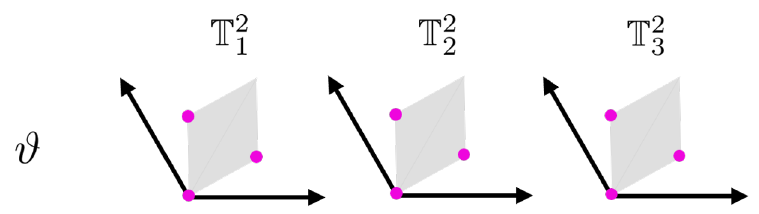
Figure 10 . An illustration of the fixed points in the Z 3 − 1 − 1 orbifold. Their location in the three tori is denoted